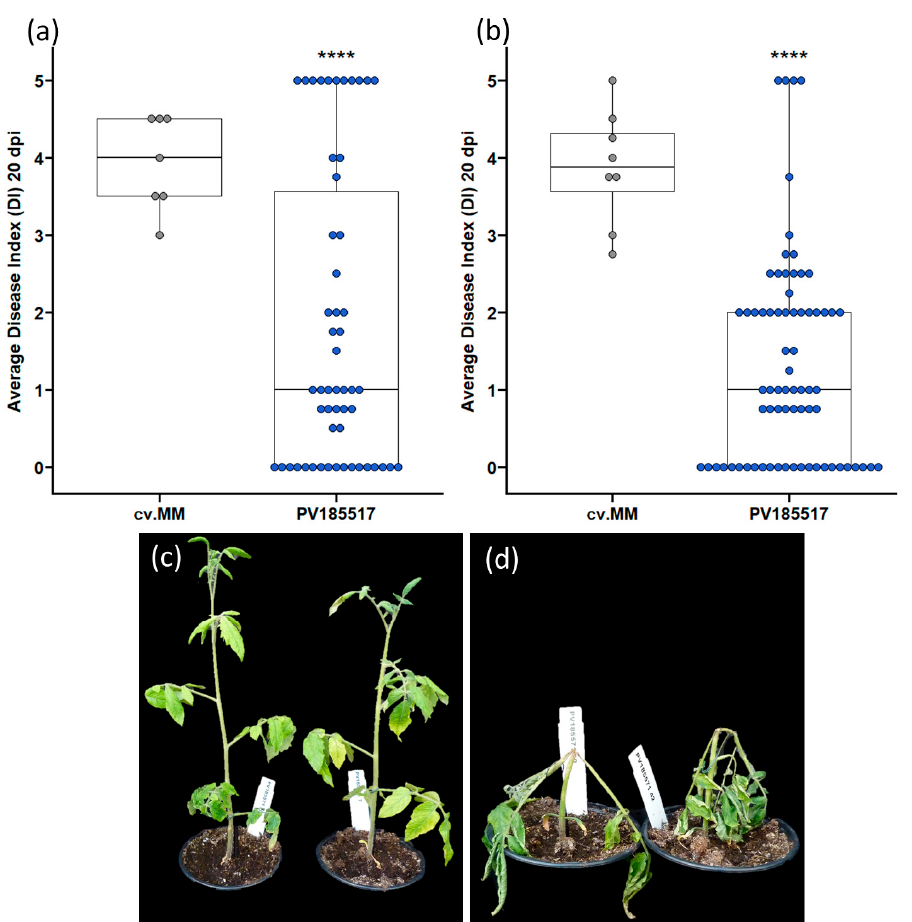
Figure 2. Phenotypic evaluation of line PV185517. ( a , b ) Average disease index (DI) of introgression line PV185517 and the susceptible background cv. MM at 20 days after inoculation with Clavibacter michiganensis NCPBB382. ( a , b ) represent two independent experiments. Phenotype of ( c ) tolerant plants and ( d ) susceptible plants in the PV185517 family. Centre lines indicate medians; the box limits indicate the 25th and 75th percentiles. (Student’s t -test, **** p ≤ 0.00).